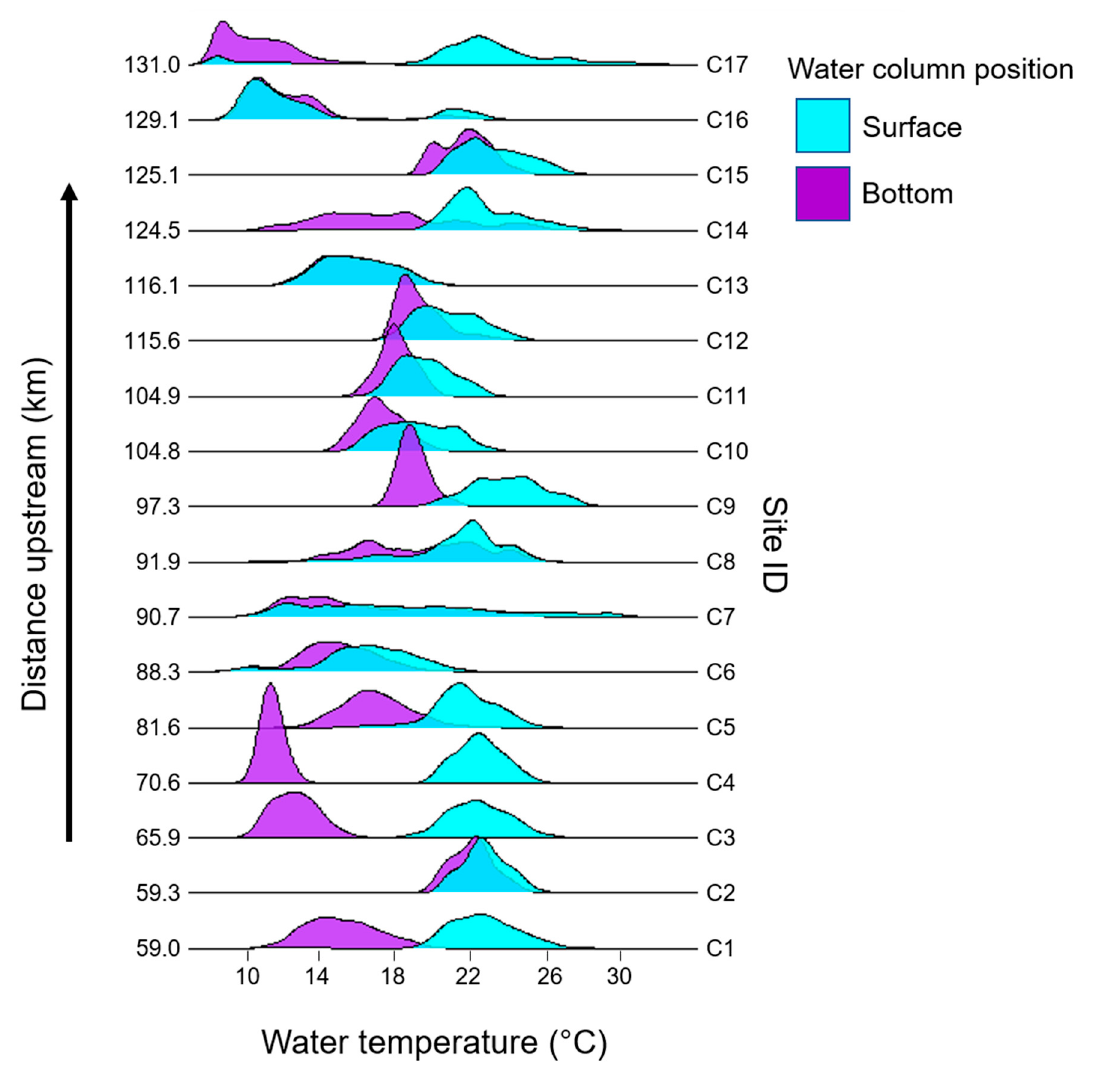
Figure 3. Water temperatures in tributary confluences (rows) measured from 17 August to 13 September 2017 with instream temperature loggers. Bottom (purple) and surface (cyan) hourly water temperature distributions illustrate the extent of vertical thermal stratification.